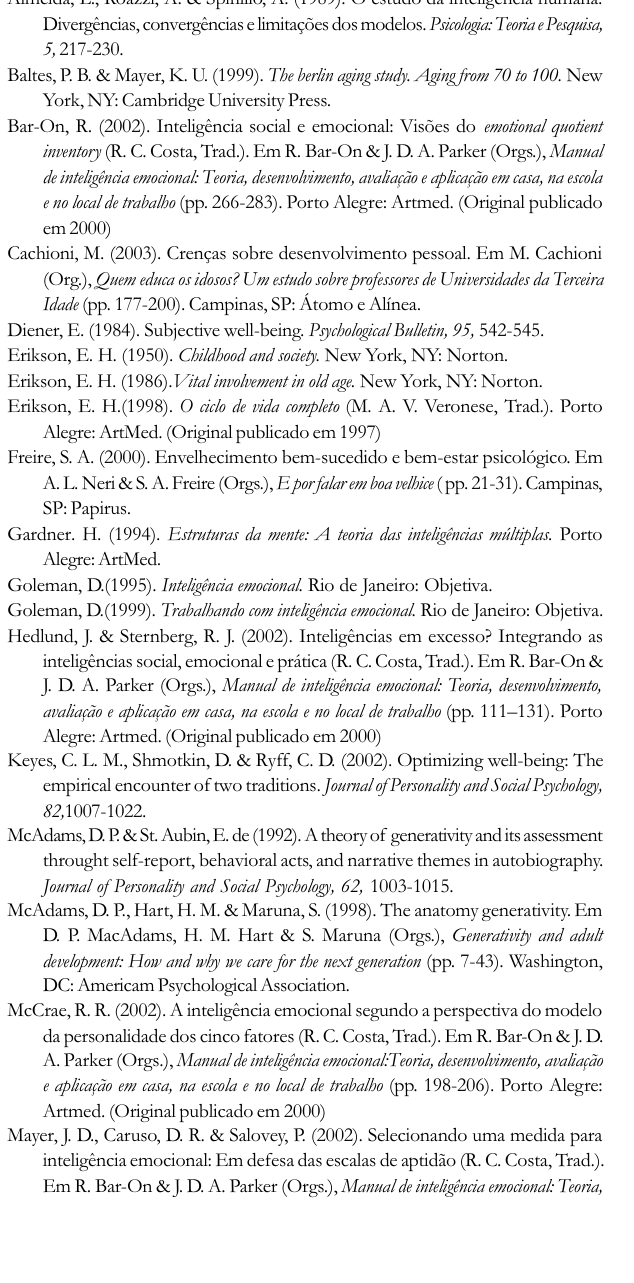
Almeida, L., Roazzi, A. & Spinillo, A. (1989). O estudo da inteligŒncia